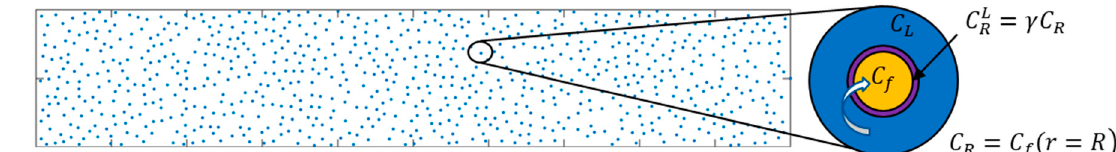
Figure 1. Schematic of the system. The species can be transported from the bulk liquid across the boundary layer and into the fiber, where it can diffuse and react within the fiber’s pores.